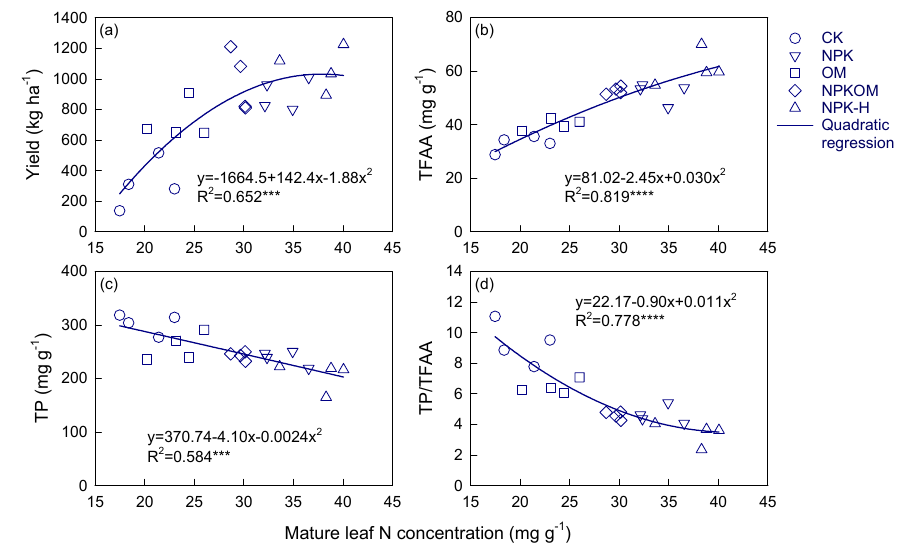
Figure 3. Relation of tea yield ( a ), total free amino acid (TFAA, b ), total polyphenol (TP, c ), and the ratio of TP/TFAA ( d ) in young shoots with the N concentration in mature leaves on April 21, 2020. Quadratic regression lines are indicated with equations, R 2 values, and significance levels (***, p < 0.001; ****, p < 0.0001). The amounts of N, P, and K in young shoots were all significantly increased by fertilization and mostly by NPK-H (Table 3). The agronomic use efficiencies of N (AE N ), P (AE P ), and the sum (AE sum ) were significantly higher in NPKOM and NPK than in NPK-H and OM. The agronomic use efficiency of K fertilizers (AE K ) was higher in OM and NPKOM than in NPK and NPK-H (Table 3). The theoretical agronomic use efficiencies (AE mix ) of N, P, and K and their sum for NPKOM according to Equation (2) were 1.32, 2.97, 3.08, and 0.71, respectively. All AE mix values were lower than their counterparts of NPKOM presented in Table 3. Table 3. Amount of nutrients in harvested young shoots, agronomic nutrient use efficiency (AE), and greenhouse gas emissions scaled per area (GHG A ), yield (GHG Y ), and profit (GHG P ).